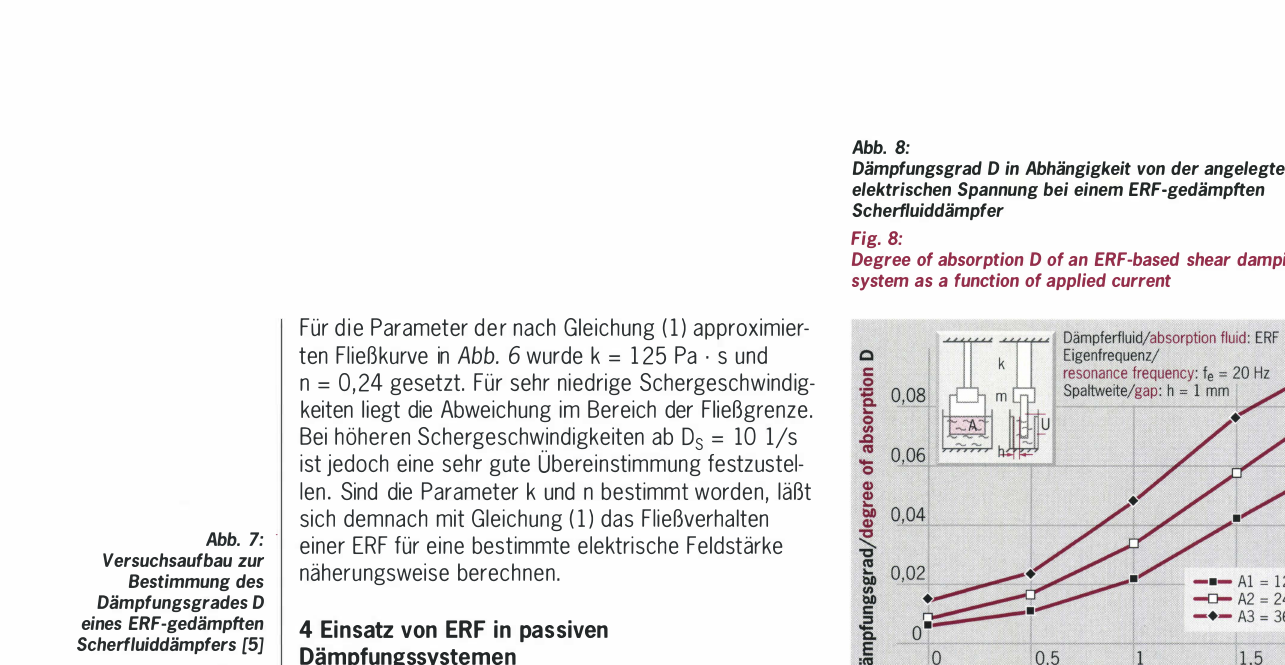
Fig. 7: Experimental setup for